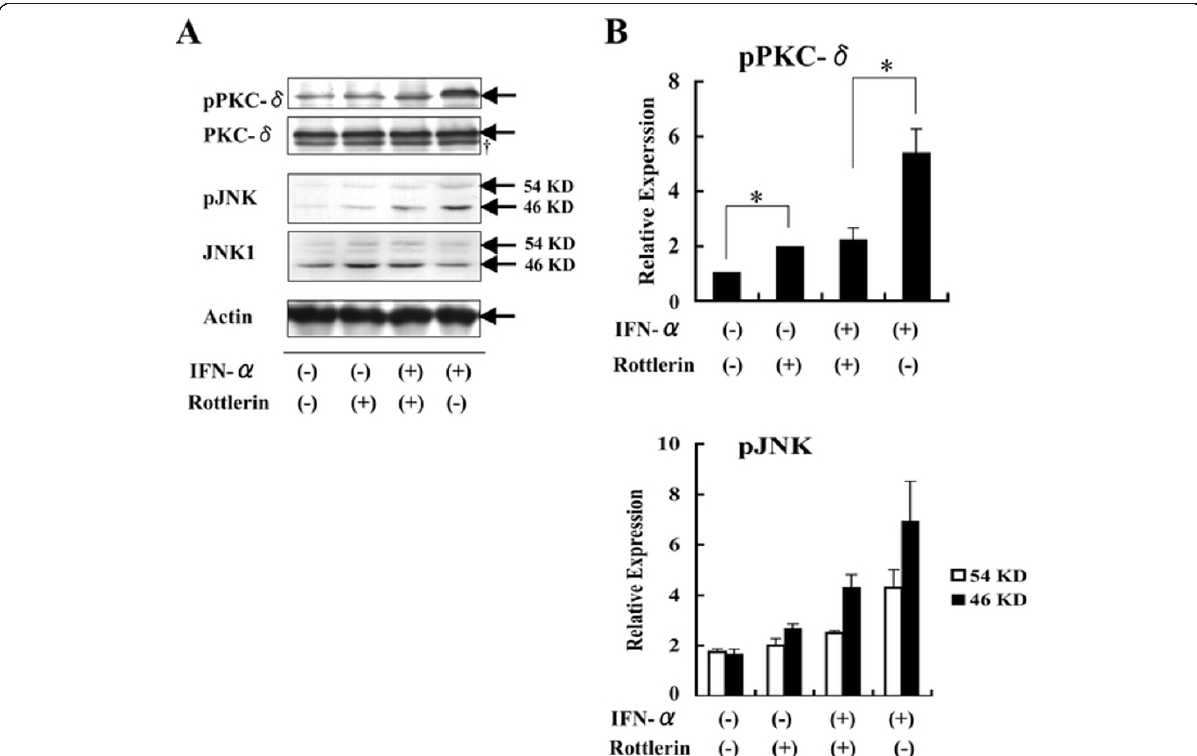
Figure 2 PKC- δ inhibitor rottlerin abrogates IFN- a -induced phosphorylation of PKC- δ . Daudi cells pretreated with 1 μ M rottlerin for 1 h were stimulated with 1,000 U/ml IFN- a for 6 h, followed by assays for levels of phospho-PKC- δ and phospho-JNK (A). Arrows indicate specific bands for pPKC- δ , PKC- δ , pJNK, JNK1, and Actin, respectively. † , non-specific band. Results are expressed as relative expression: phospho-PKC or phospho-JNK levels normalized to actin levels with the indicated stimulators are divided by phospho-PKC- δ or phospho-JNK levels normalized to actin levels without stimulation (B). Each point represents mean ± SD from three independent experiments (B&C). *Significantly different ( p < 0.05) from control without